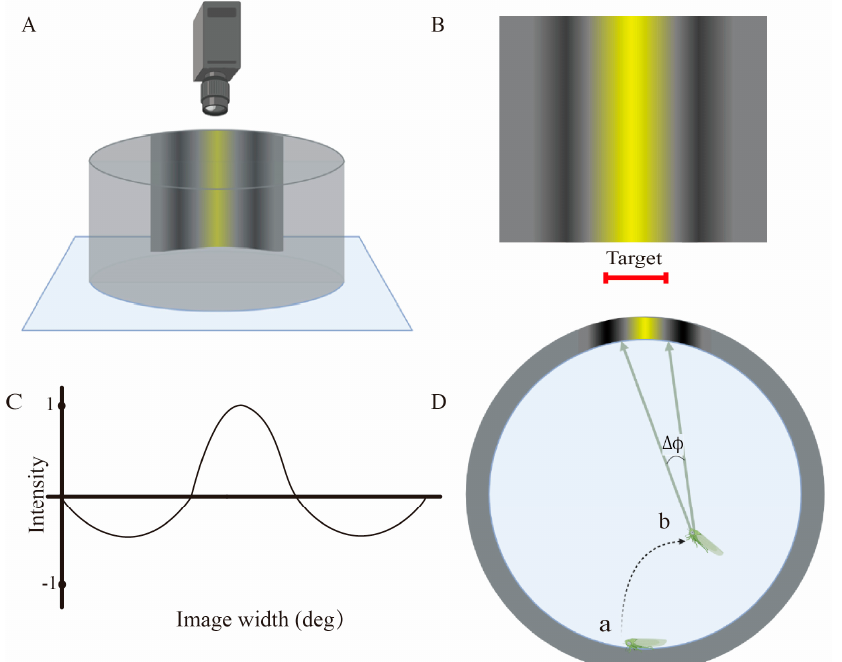
Figure 2. Diagrammatic drawing of the behavioral experiment setup. ( A ) Side view of the experimental setup, with the high-speed camera above. In the middle is the behavioral reaction setup (15 cm diameter, 5 cm height). A yellow–black grating with 5 × 5 cm patches was placed on the side wall, and the overall brightness of the grating was the same as that of the gray background on the side wall. Below is the luminescent background plate with a light intensity of 815 μ w/cm − 2 . ( B, C ) The yellow–black grating and its brightness correspond to the piecewise sine stimulus. ( D ) Top view of the behavioral experiment setup. Empoasca onukii were released at point a and conducted spontaneous search behavior to point b ; during this time, if E. onukii exhibited a recognition response to the yellow–black grating, the angle Δ ϕ between the individual and the target grating was measured.